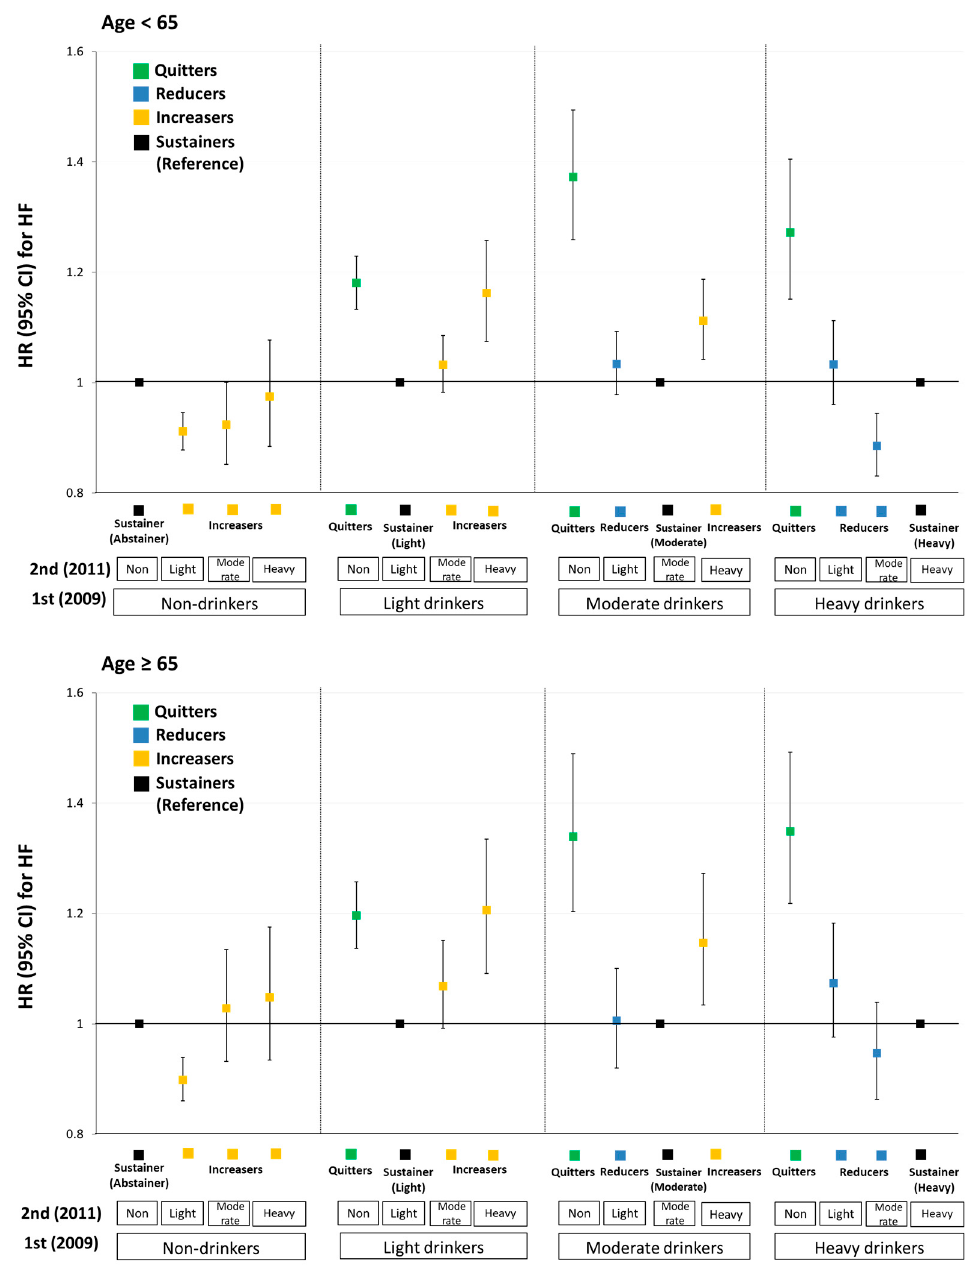
Figure 3. Changes in alcohol consumption amount and risk of congestive heart failure by age. All HRs were adjusted for age, sex, BMI, smoking status, physical activity, area of residence, income, hypertension, diabetes mellitus, dyslipidemia, systolic blood pressure, fasting glucose level, total cholesterol level, and serum creatinine level. HR, hazard ratio; CI, confidence interval.